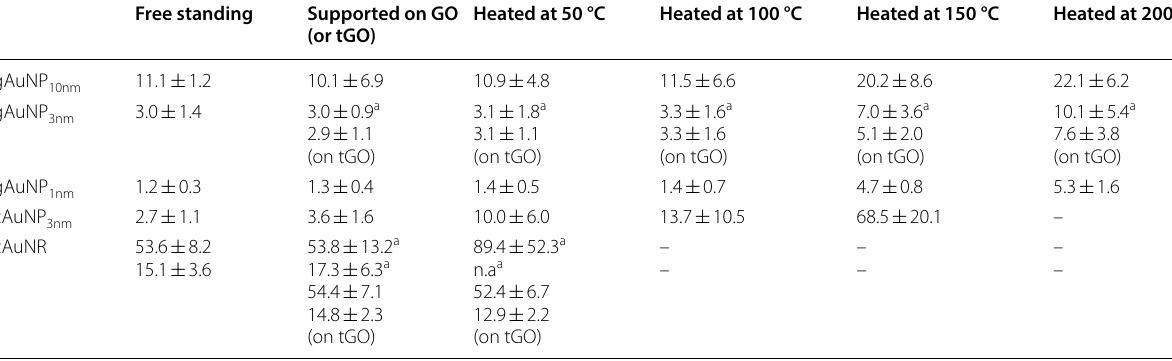
Table 1 Core size evolution of gold nanoparticles and nanorods